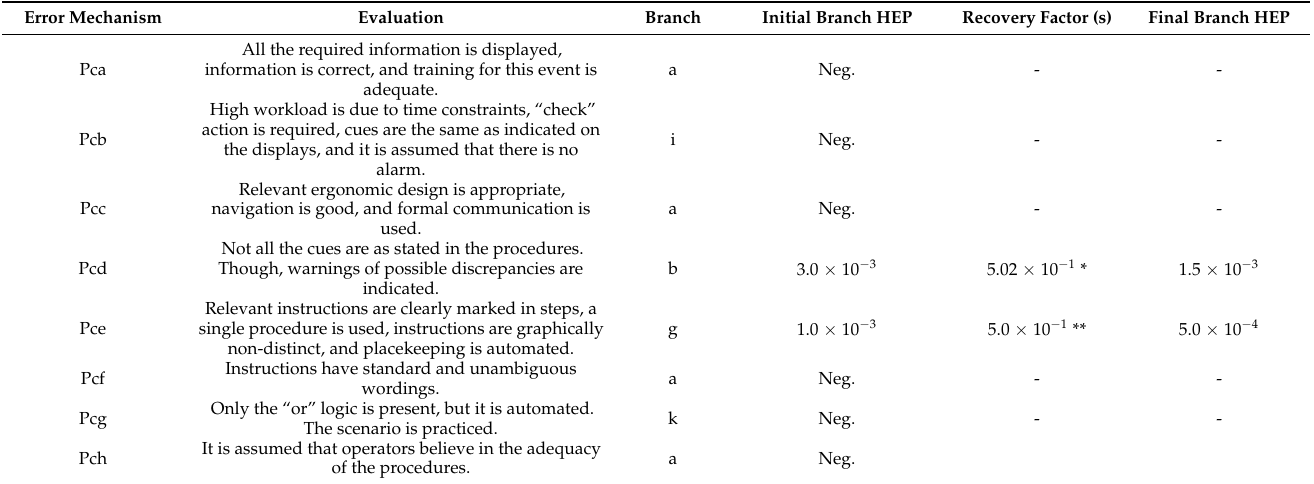
Table 10. Evaluating the diagnosis error for recovery of an auxiliary feedwater actuation signal. Error